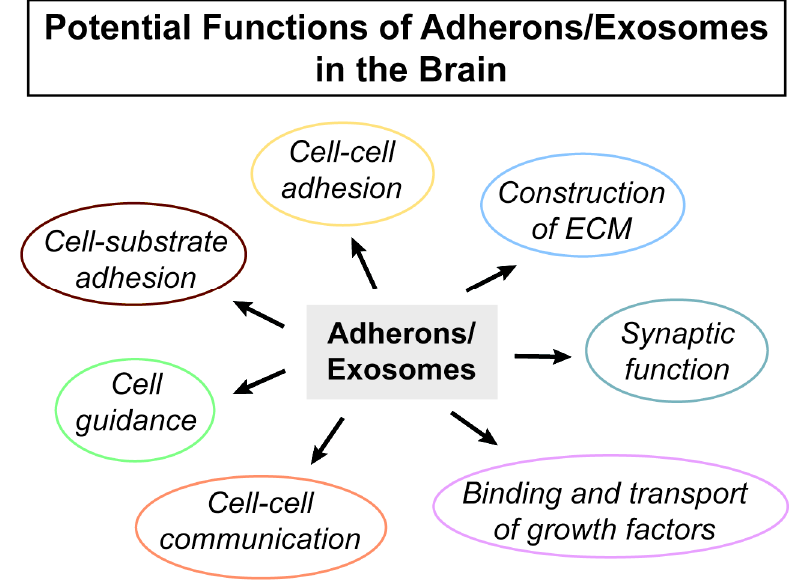
Figure 2. Potential functions of adherons/exosomes in the brain.